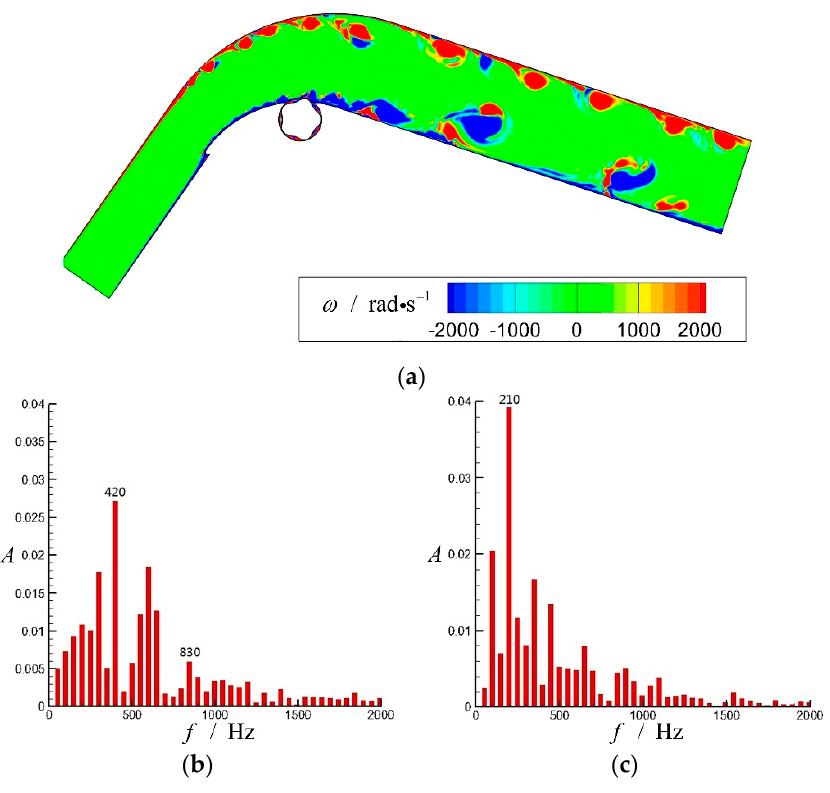
Figure 10. Numerical simulation of the diffuser with effective control ( (cid:101) V = 0.3, (cid:101) f = 2.3, and f TWW = 830 Hz): ( a ) Vorticity ( ω ) contour; ( b ) Velocity FFT of S1 ( A − f ); ( c ) Velocity FFT of S2 ( A − f ).